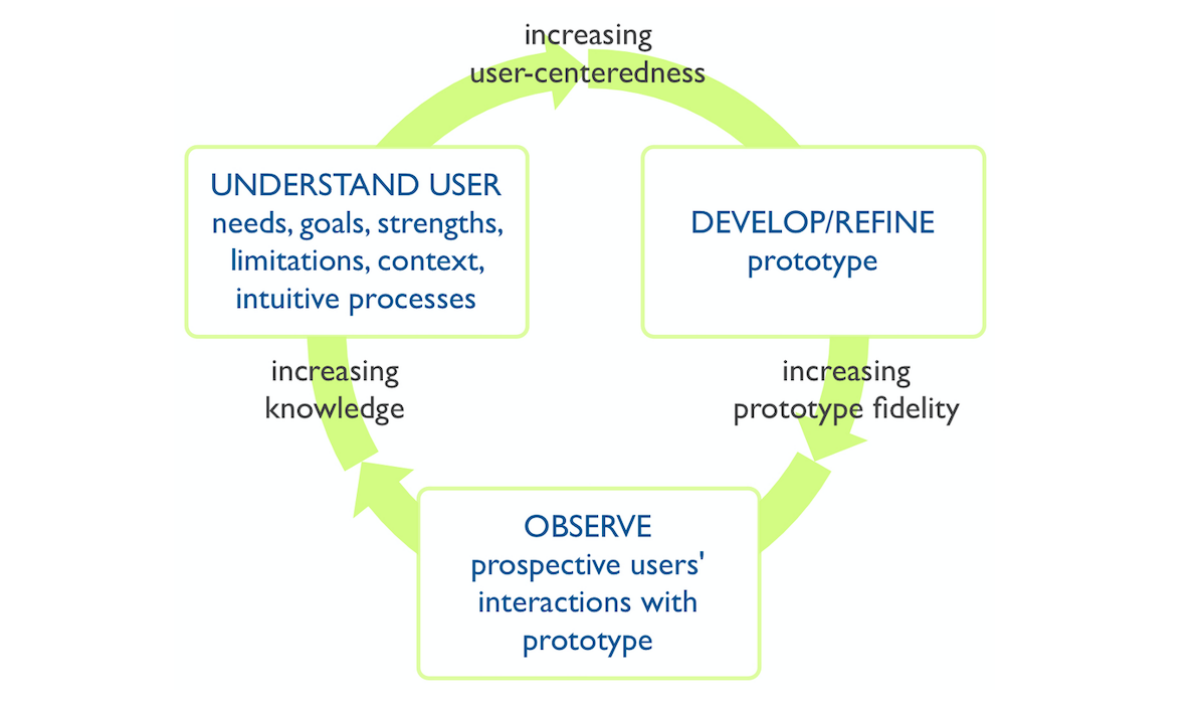
Figure 1. User-centered design